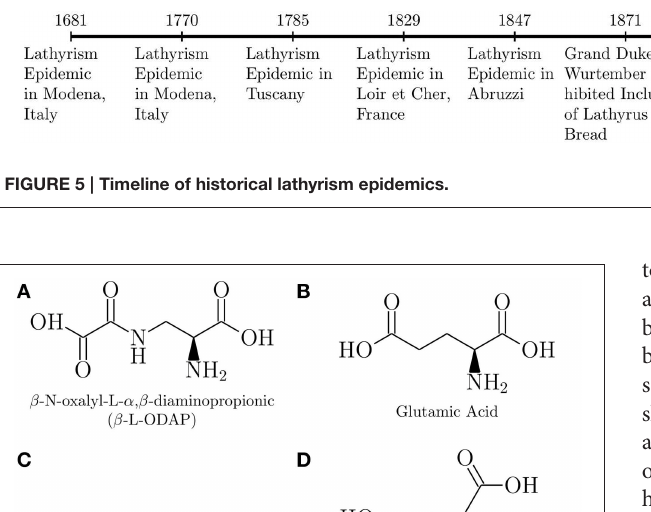
( Figures 4G,I ). Phase plot showed that the rhythm of lathyrism lags that of ENSO ( Figure 4K